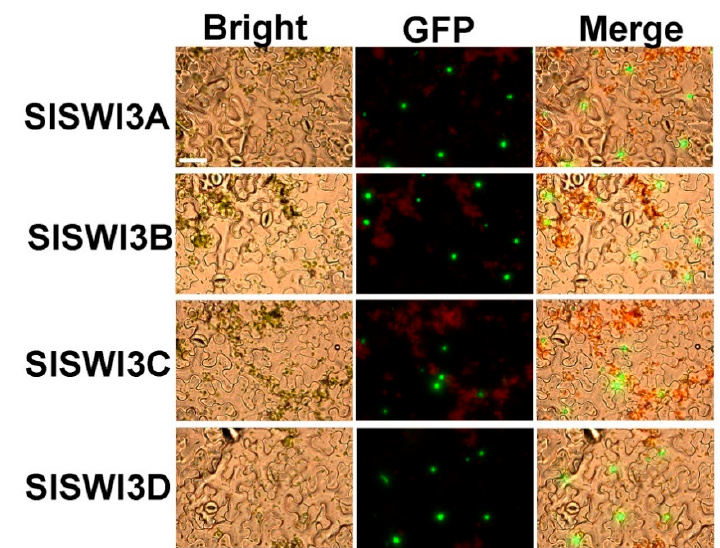
Figure 2. Subcellular localization of SlSWI3s. A. tumefaciens strain GV3103 harboring SlSWI3s-GFP constructs were infiltrated into young but fully expanded leaves of tobacco. After growth at 23 °C for 48 h, the epidermis of tobacco leaves were used to determine the distribution of the fusion protein using a confocal fluorescence microscope. The MADS-box transcriptional factor SlRIN was used as a positive control for localization of a nuclear protein. Bars = 50 µ m. Similar results were obtained in three independent experiments, and one representative result was shown.